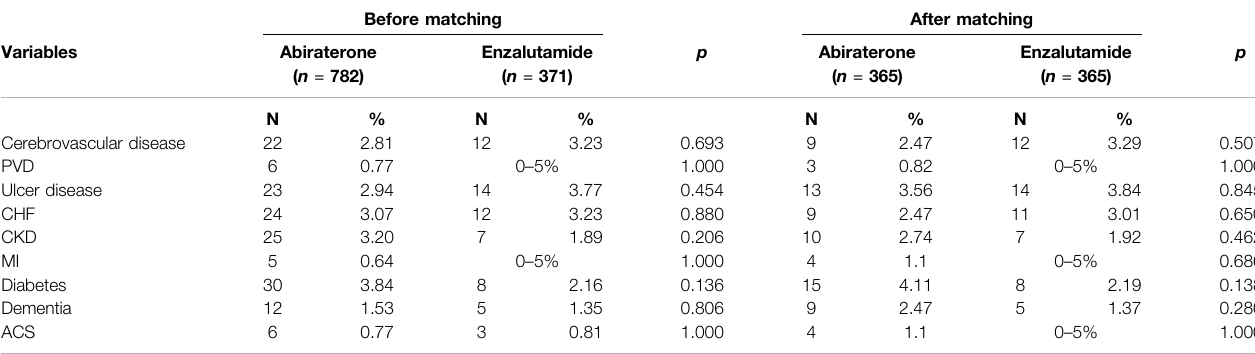
TABLE 2 | Newly developed comorbidities.